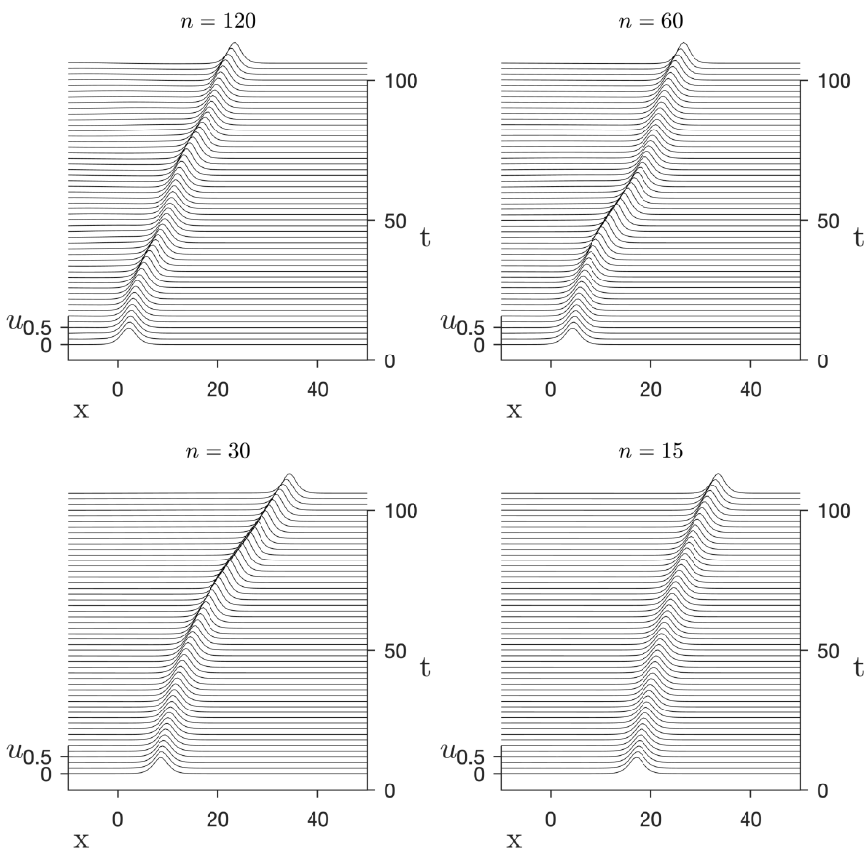
Figure 2. Solitary wave solutions over the periodic forcing. Parameters: ∆ = − 2 a , x 0 = + π /2 q , A = − 1.